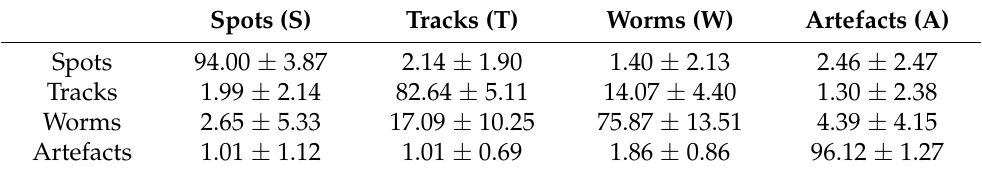
Figure 6. Example of best and worse approximations. C means correct (judge labeled) class, p ispredicted class, and MSE is a mean squared error between judge-labeled value and predicted value.Predictions were performed using a neural network with the VGG16 input layer. The MSE of theimages in the first row is below 0.005. The images ( a – d ) represent correct assignments, while ( e – h ) illustrate cases of misclassification. Table 8. Confusion matrix of network with input VGG16 and threshold scheme (8) t = 0.50. Data remaining = 85.36 ± 1.79 (S 79.92% ± 4.37%; T 80.03 ± 3.40; W 56.98 ± 16.92; A 97.89 ± 1.41), recognition rate = 92.11 ± 1.92.